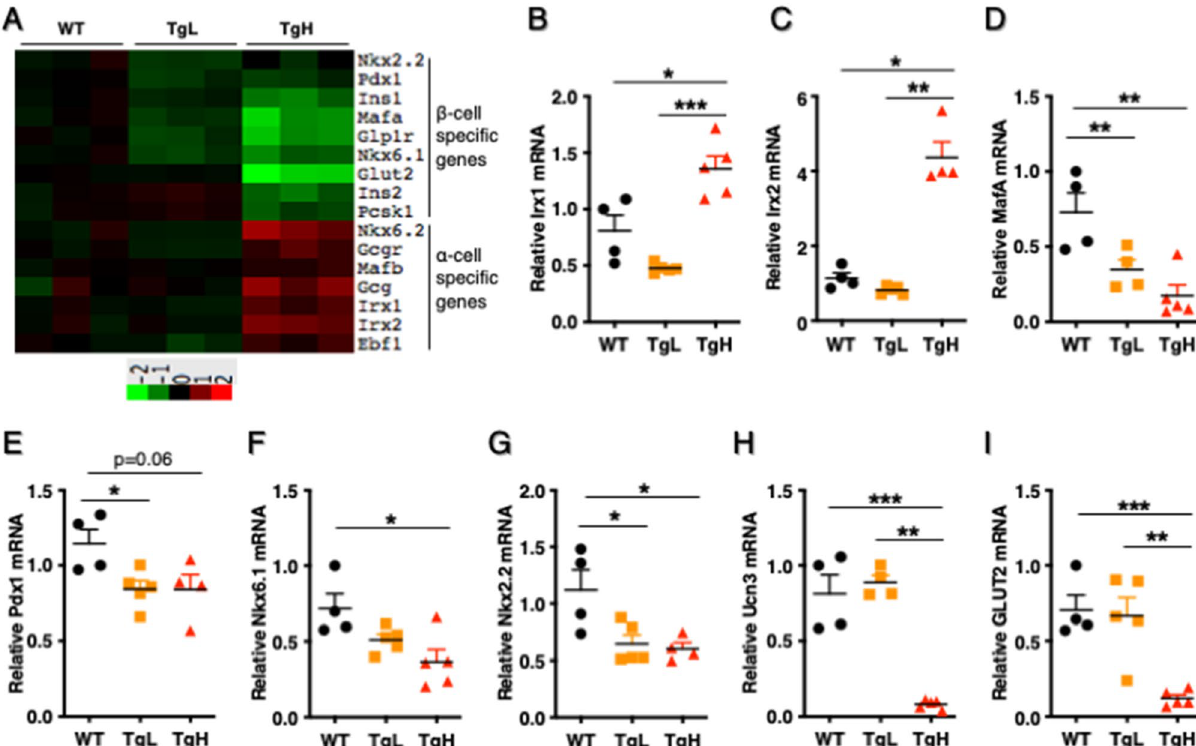
Figure 6. Transgenic overexpressed miR-30d induced downregulation of β-cell-enriched genes and upregulation of α-cell-enriched genes in TgH mice. (A) A heatmap of expression levels of major β-cell and α-cell-enriched genes revealed from RNAseq. ( B–I) RT-qPCR validated the relative mRNA expression of key genes (n = 4–5 per group). All data were presented as mean ± SEM. * p < 0.05; ** p < 0.01; or *** p < 0.001 versus